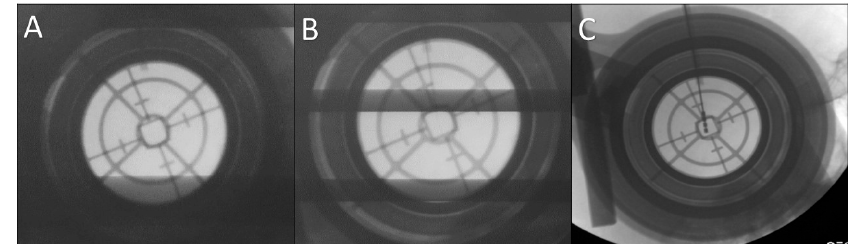
Figure 6. Fluoroscopic confirmation of the target approach. ( A ) Confirmation of the position of the stereotactic cannula; ( B ) the microelectrode is advanced to the target under fluoroscopic guidance; ( C ) the final position of the deep brain stimulation (DBS) electrode confirmed. Brain Sci. 2016 , 6 , 65